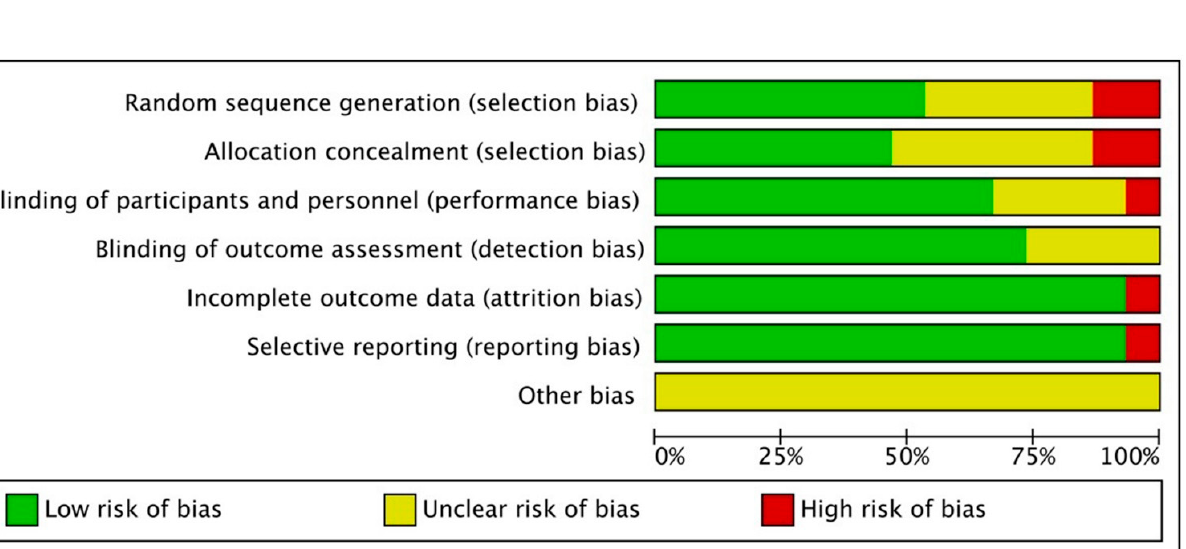
Figure 3. Risk of bias assessment. ( a ) judgements of each bias item presented as percentages across all included studies. ( b ) judgements of each bias item for each included study. 7. Discussion We estimated the relative efficacy and safety of novel biologics targeting inflammations for the treatment of OA using network meta-analysis. Despite limited sample size, we found that infliximab was the most effective treatment compared with all other biologics regarding pain relief. Moreover, according to conventional meta-analysis, etanercept was associated with greater pain relief, and tocilizumab was associated with improvement in pain and physical function, compared with placebo. All the biologics did not increase AEs and were tolerable for OA patients.